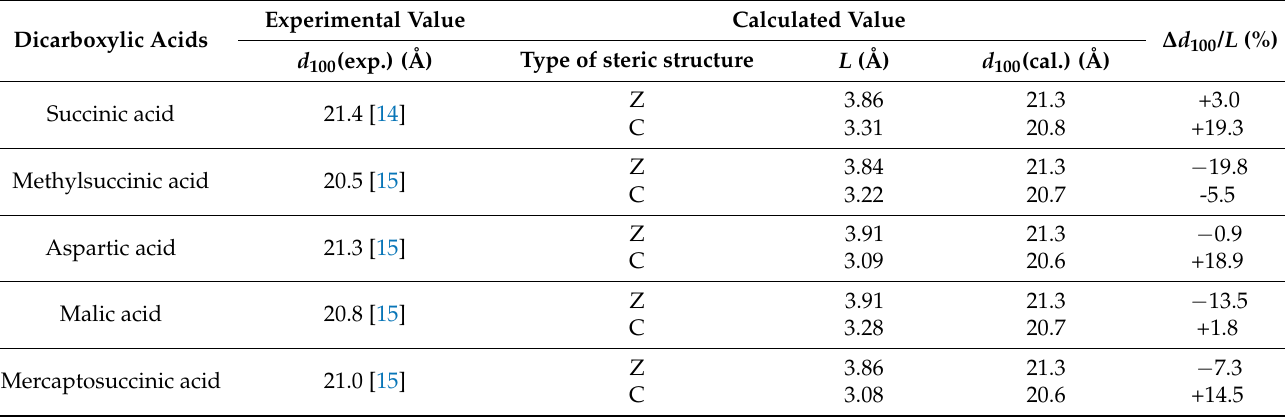
Table 2. Values of d 100 (exp.), L , d 100 (cal.), and ∆ d 100 / L for the ions of succinic acid and its derivatives incorporated in the OCP crystal. Dicarboxylic